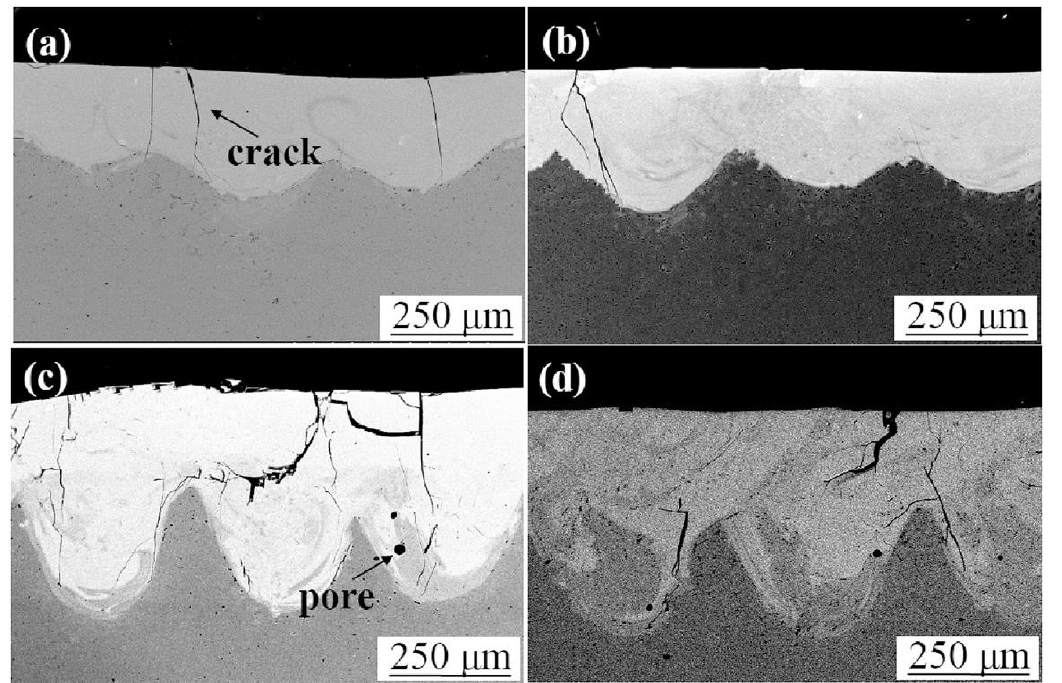
Figure 8. SEMs of the cross-sections of the LC of FeCoCrMoCBY, onto mild steel substrate with different pulse frequencies: ( a ) 0.5 Hz, ( b ) 1.0 Hz, ( c ) 1.5 Hz, ( d ) 2.5 Hz. Reproduced with permission from [31]. Copyright Elsevier, 2017.